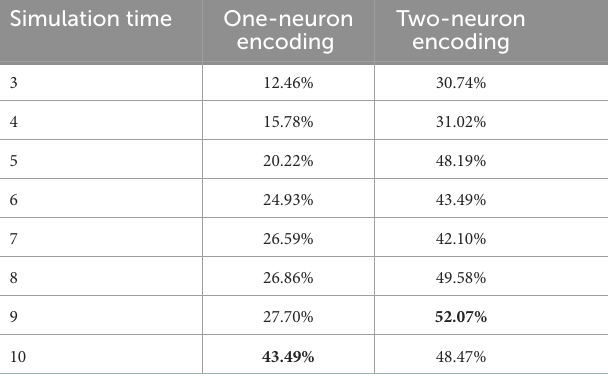
TABLE 1 Reward threshold crossing percentages across all parameter combinations for different simulation times. Simulation